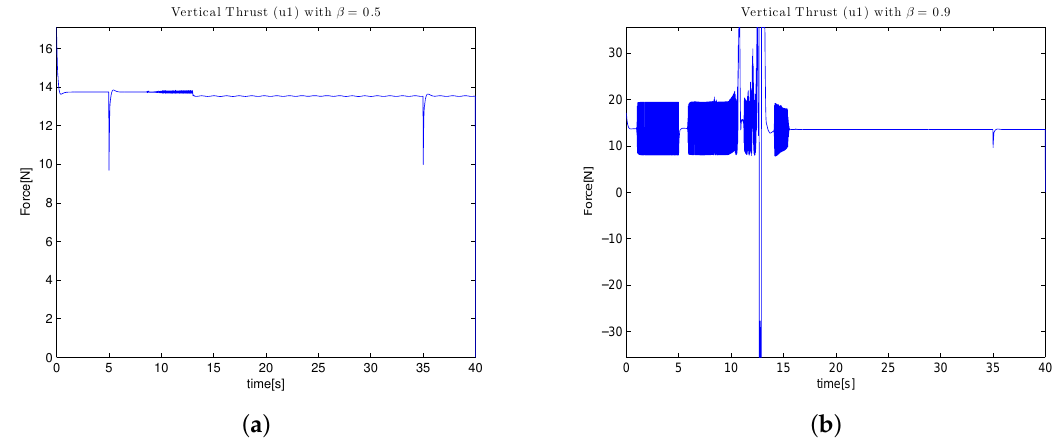
Figure 16. ( a ) Control signal u 1 with β = 0.5; ( b ) Control signal u 1 with β =